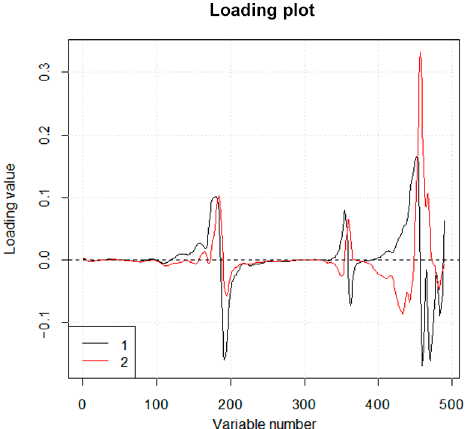
Figure 6. Results of the principal component analysis (PCA) performed on the reflection FT-IR spectral dataset in the range 1400–400 cm − 1 : PC1 versus PC2 scatter score plot ( a ) and its magnifi- cation in correspondence of the region enclosed in the dotted rectangle ( b ). Letters indicate the mock-ups under investigation; colors highlight different hematite concentrations in the paint layer as reported in the legend (i.e., H_0%, H_1%, H_2%, H_5%, and H_10%, where the letter H stands for hematite).